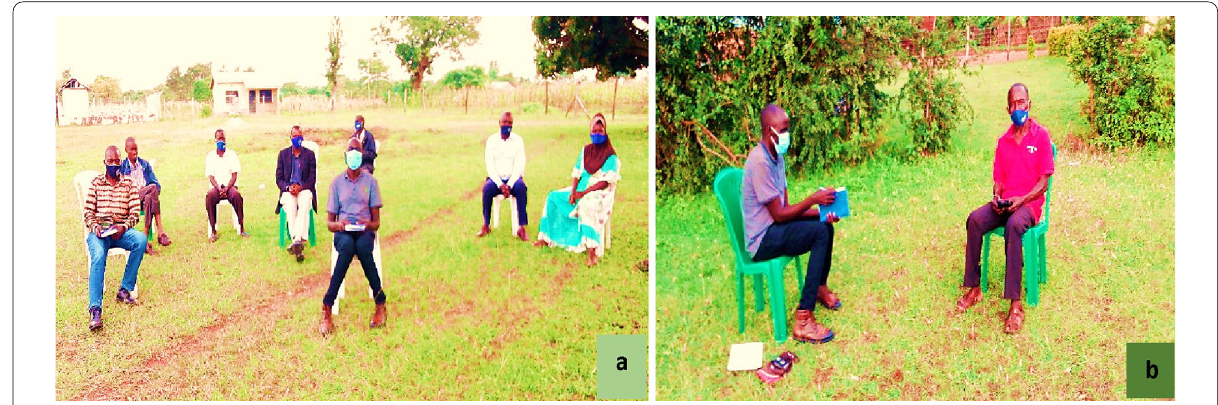
Fig. 3 A section of a FGD a and KII b in Busiu